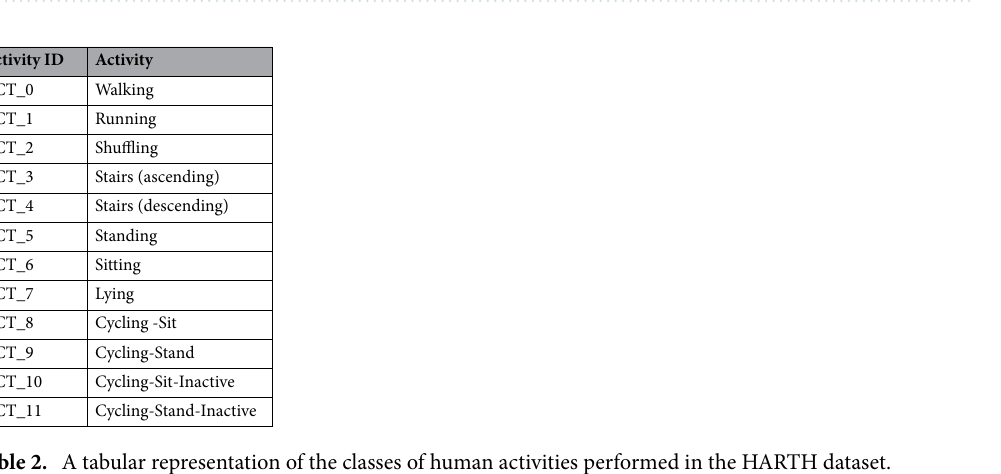
Figure 2. Class-wise distribution of human activities in the HARTH dataset.